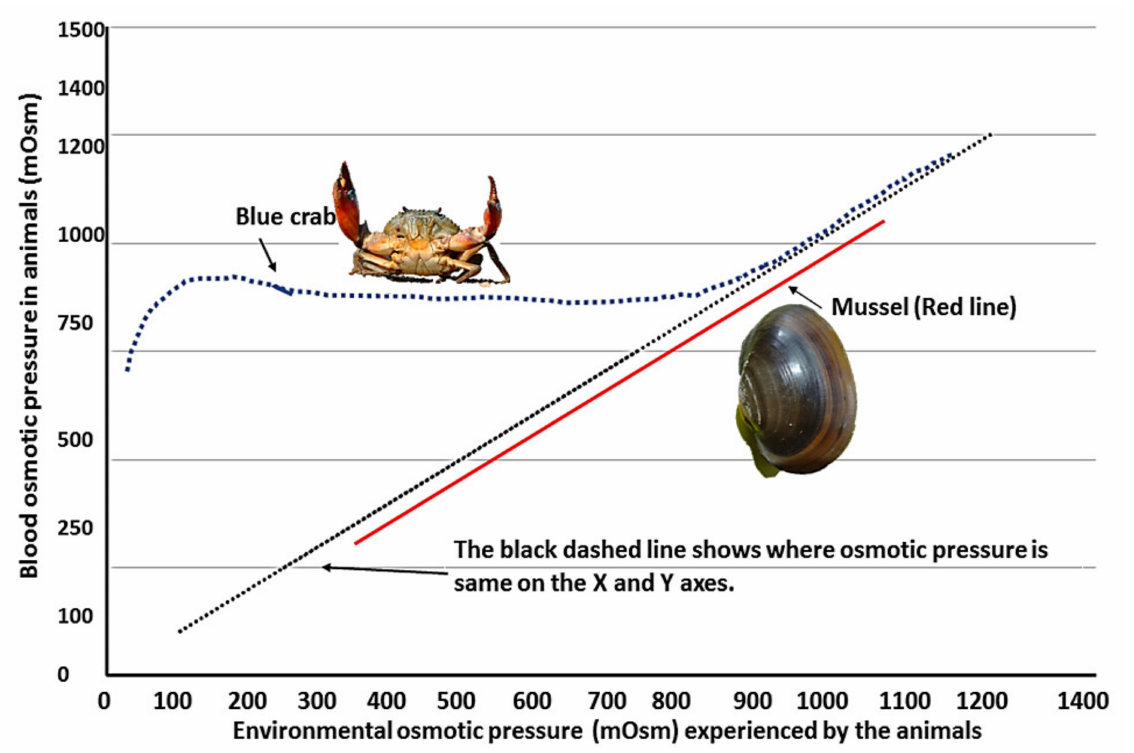
Figure 7. Effects of salinity on maintaining environmental and bodily osmotic pressure: The bodily osmotic pressure rises sharply under hypersaline states in osmoconformers such as mussels, while the reverse is observed in osmoregulators such as crabs, for example, which can regulate their bodly osmotic pressure up to 1000 mOsm under environmental osmotic conditions. However, higher environmental osmotic pressure under hypersalinity misbalances the osmoregulation process in many aquatic animals, irrespective of their osmoconformer status or regulatory capacity. The photo of the species was collected from Google Images with a creative common attribution